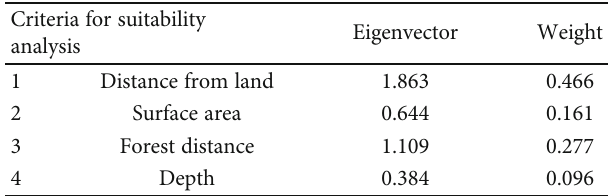
Table 5: Eigenvector and weights of the criteria fl oating solar PV